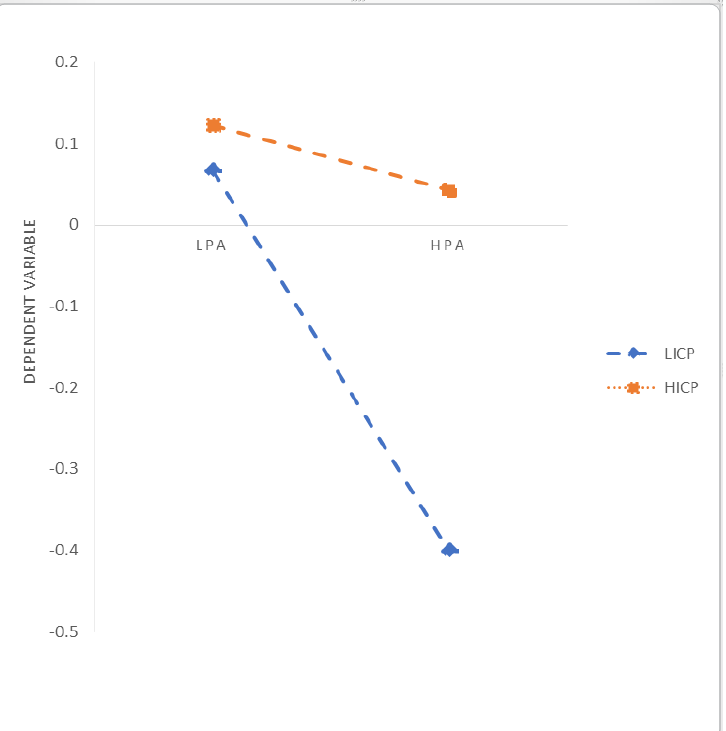
Figure 3. Moderating Effects of Internal Control Personality (Parental Alienation). Notes: LPT: Low Parental Trust, HPT: High Parental Trust; LPC: Low Parental Communication, HPC: High Parental Communication; LPA: Low Parental Alienation, HPA: High Parental Alienation; LICP: Low Internal Control Personality, HICP: High Internal Control